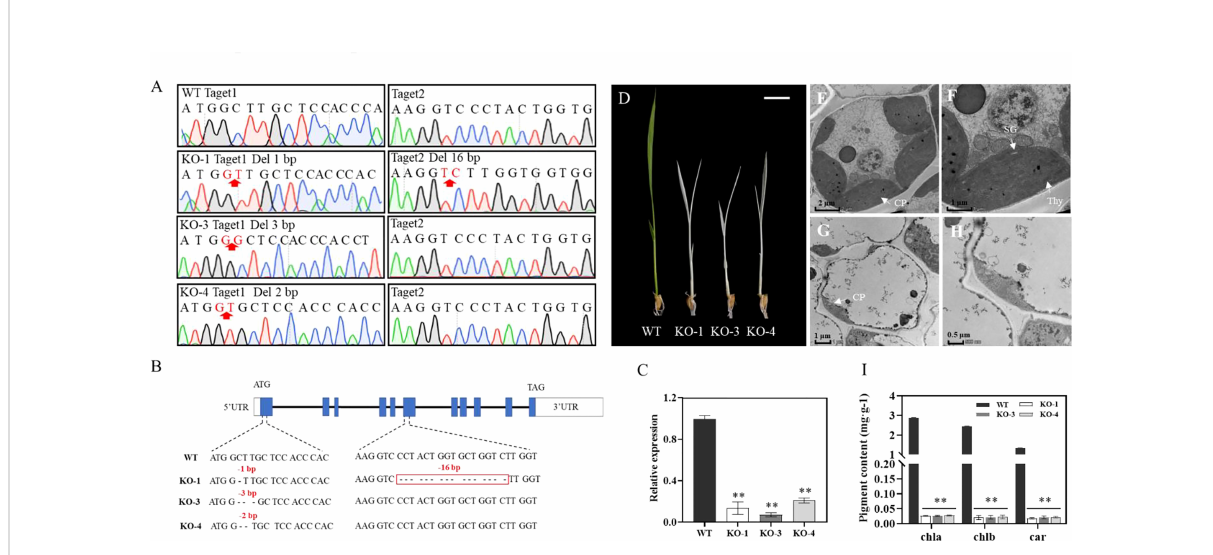
FIGURE 4 Transgenic con fi rmation of the role of OsIspE in regulating leaf color. (A, B) OsIspE -Cas9 lines (KO-1, KO-3, KO-4) containing deletion mutations were con fi rmed via sequencing. (C) RT-qPCR analysis of OsIspE in ZH11 and OsIspE -Cas9 lines. (D) Phenotypic analysis of OsIspE- Cas9 lines at 10 DAP. Bars=1cm. (F – H) Transmission electron microscopy analysis of the leaves of ZH11 (E, F) and KO - 1 (G, H) at the three-leaf stage. CP, chloroplast; SG, starch granule; Thy, thylakoid lamellar. Bar=2 m m (E) , 1 m m (F, G) and 0.5 m m (H, I) Chlorophyll (Chla, Chlb) and carotenoid (Car) levels of ZH11 and OsIspE -Cas9 lines at 10 DAP. ** P <